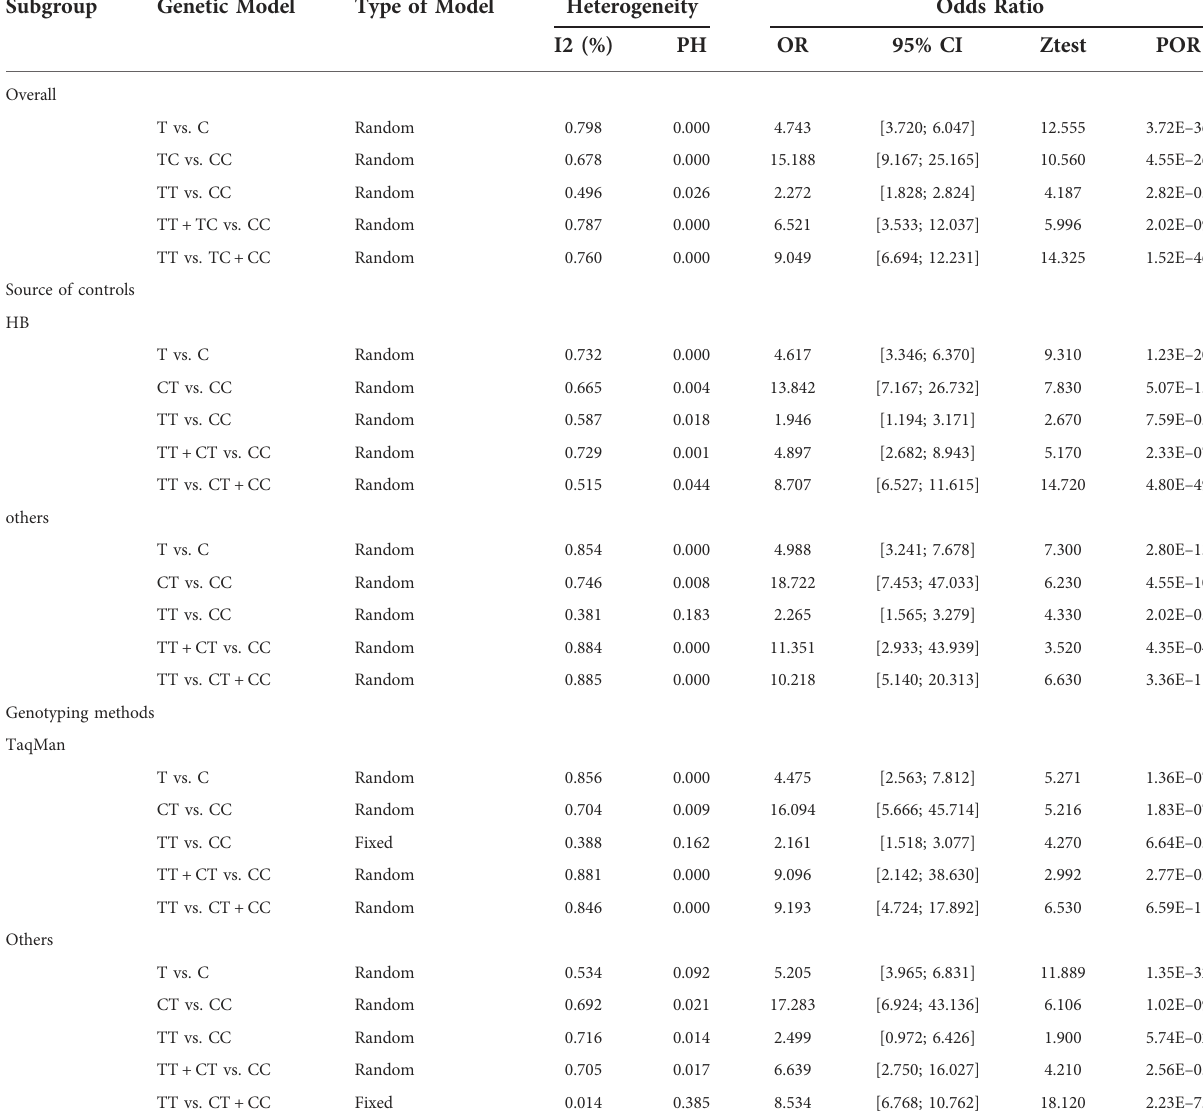
TABLE 3 Analysis results of the association between rs2435357 and HSCR risk.